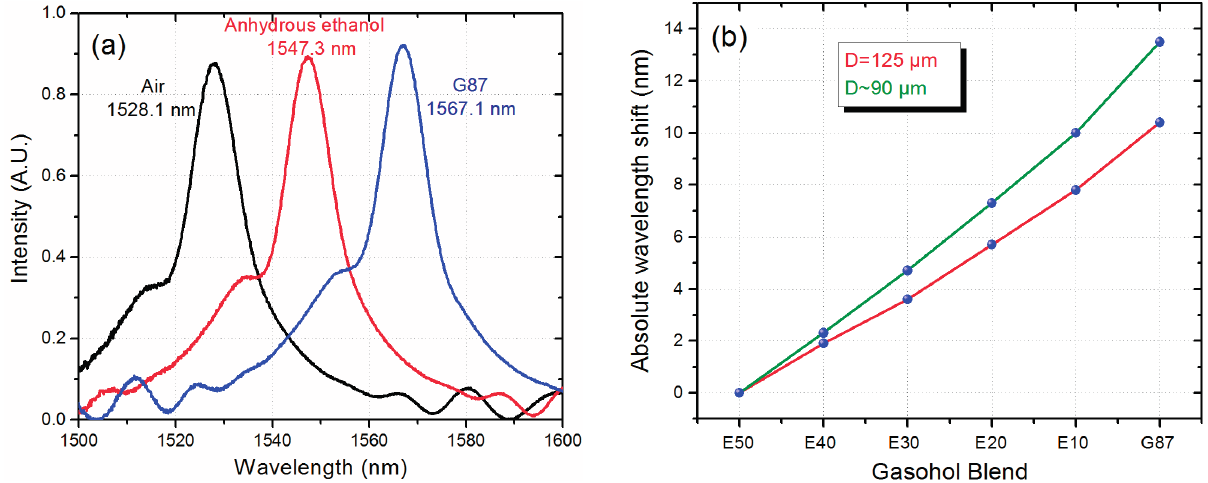
Figure 5. ( a ) Spectral response of the MMI sensor for AE and G87 gasoline (No-Core MMF diameter of 90 µm); ( b) Absolute peak wavelength shift of both MMI sensors as a function of the gasohol